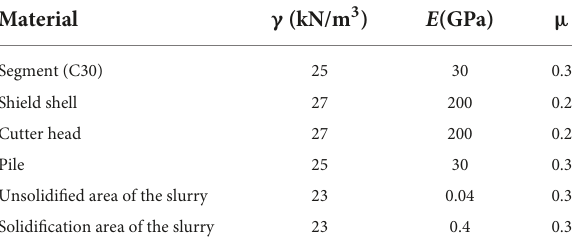
TABLE 2 Simulation unit parameters.